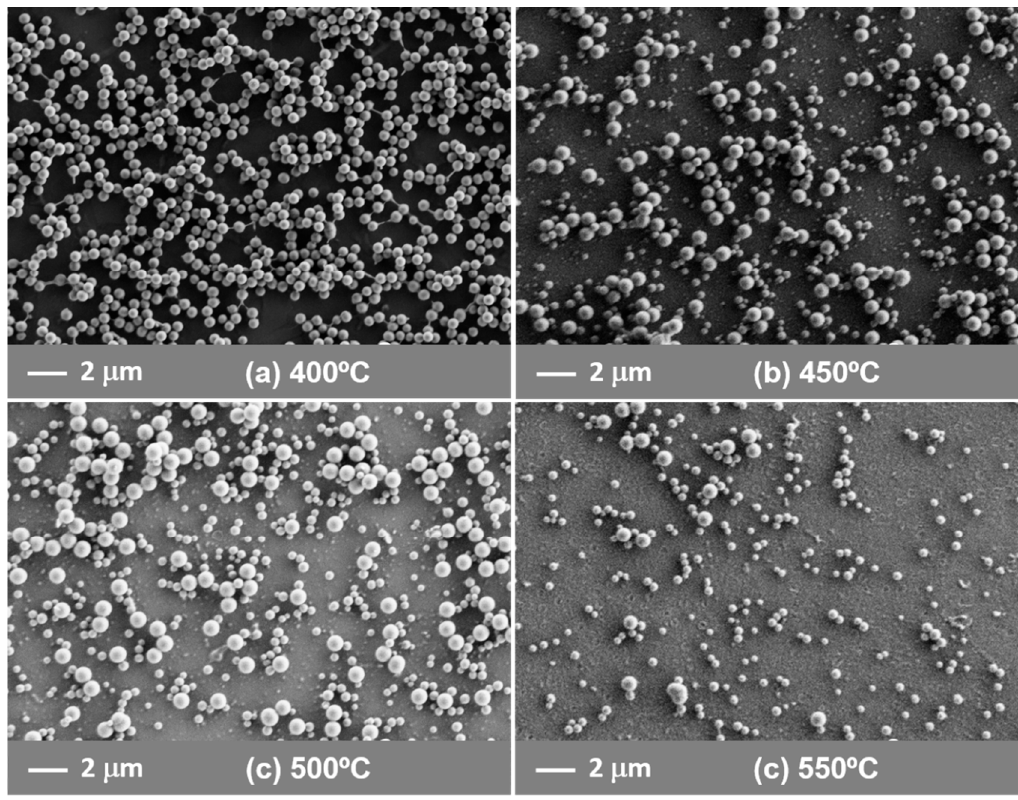
Figure 8. SEM images of silica coatings aged for 5 days and dipped for 5 min four times calcined at ( a ) 400, ( b ) 450, ( c ) 500 and ( d ) 550 °C.